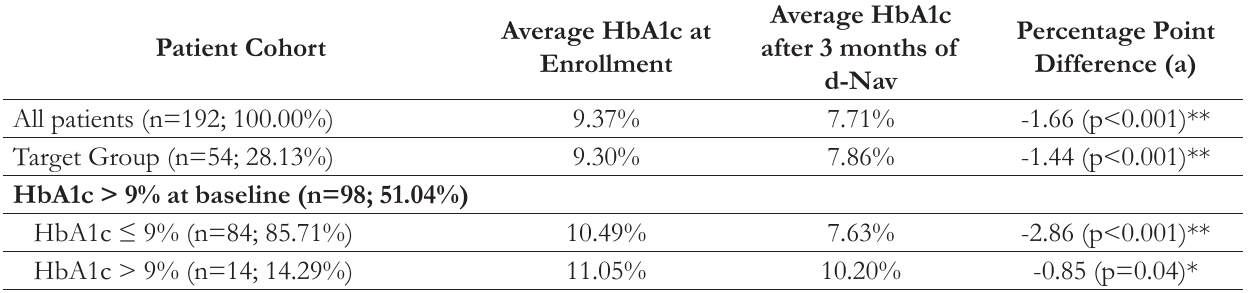
Table 3. Effect of d-Nav on Patient HbA1c Levels at 90-days (n=192) Patient